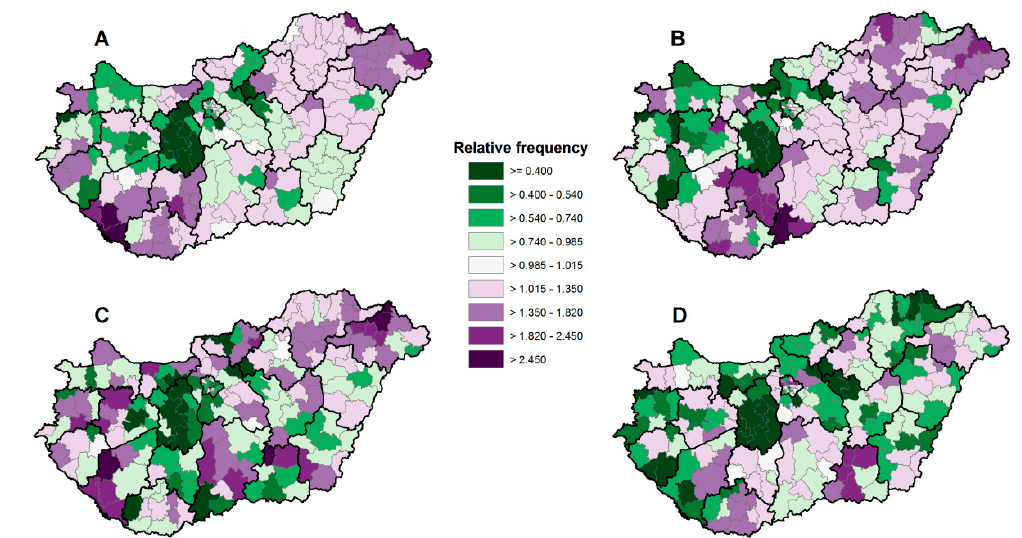
Figure 2. The spatial distribution of the relative frequencies of Clopidogrel ( A ), Syncumar ( B ), Warfarin ( C ), and Xarelto ( D ) prescription at the district level, Hungary, 2016.